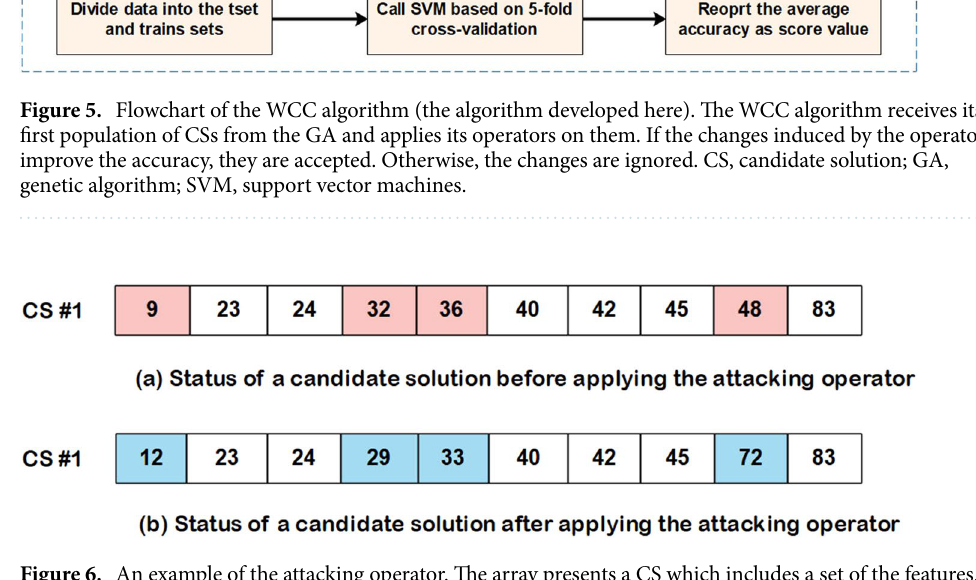
Figure 6. An example of the attacking operator. The array presents a CS which includes a set of the features. ( a ) Some indices of a CS are randomly chosen. The values of the selected indices have been highlighted by the pink colors. ( b ) The values of the determined indices are replaced by other randomly generated values. The blue colors show the replaced values. If repeated values appear, one of them remains and others are eliminated. The size of a CS may be reduced after applying the attacking operator. CS, candidate